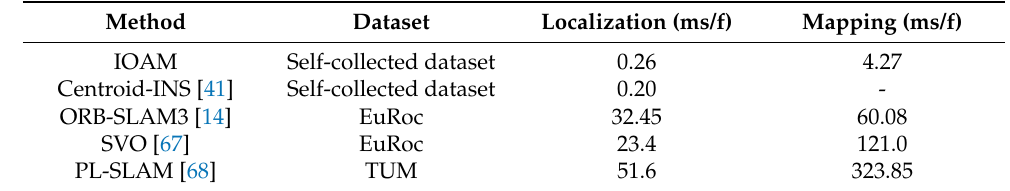
Table 7. Comparison of mean runtime (ms/frame) of localization and mapping with proposed IOAM with other state-of-the-arts.